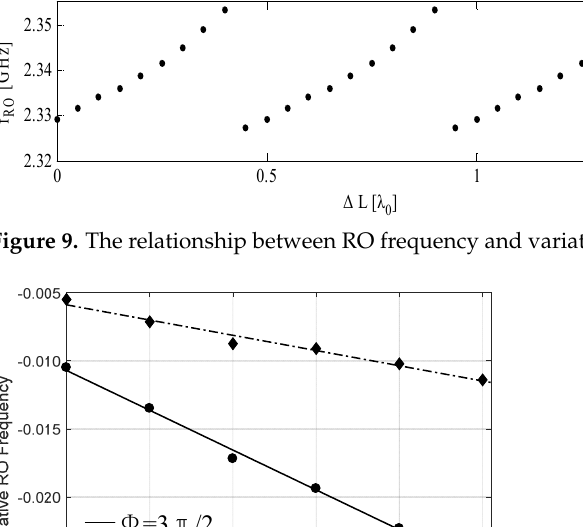
Figure 10. Fitting curves of RO frequency for α measurement (adapted from [65]).